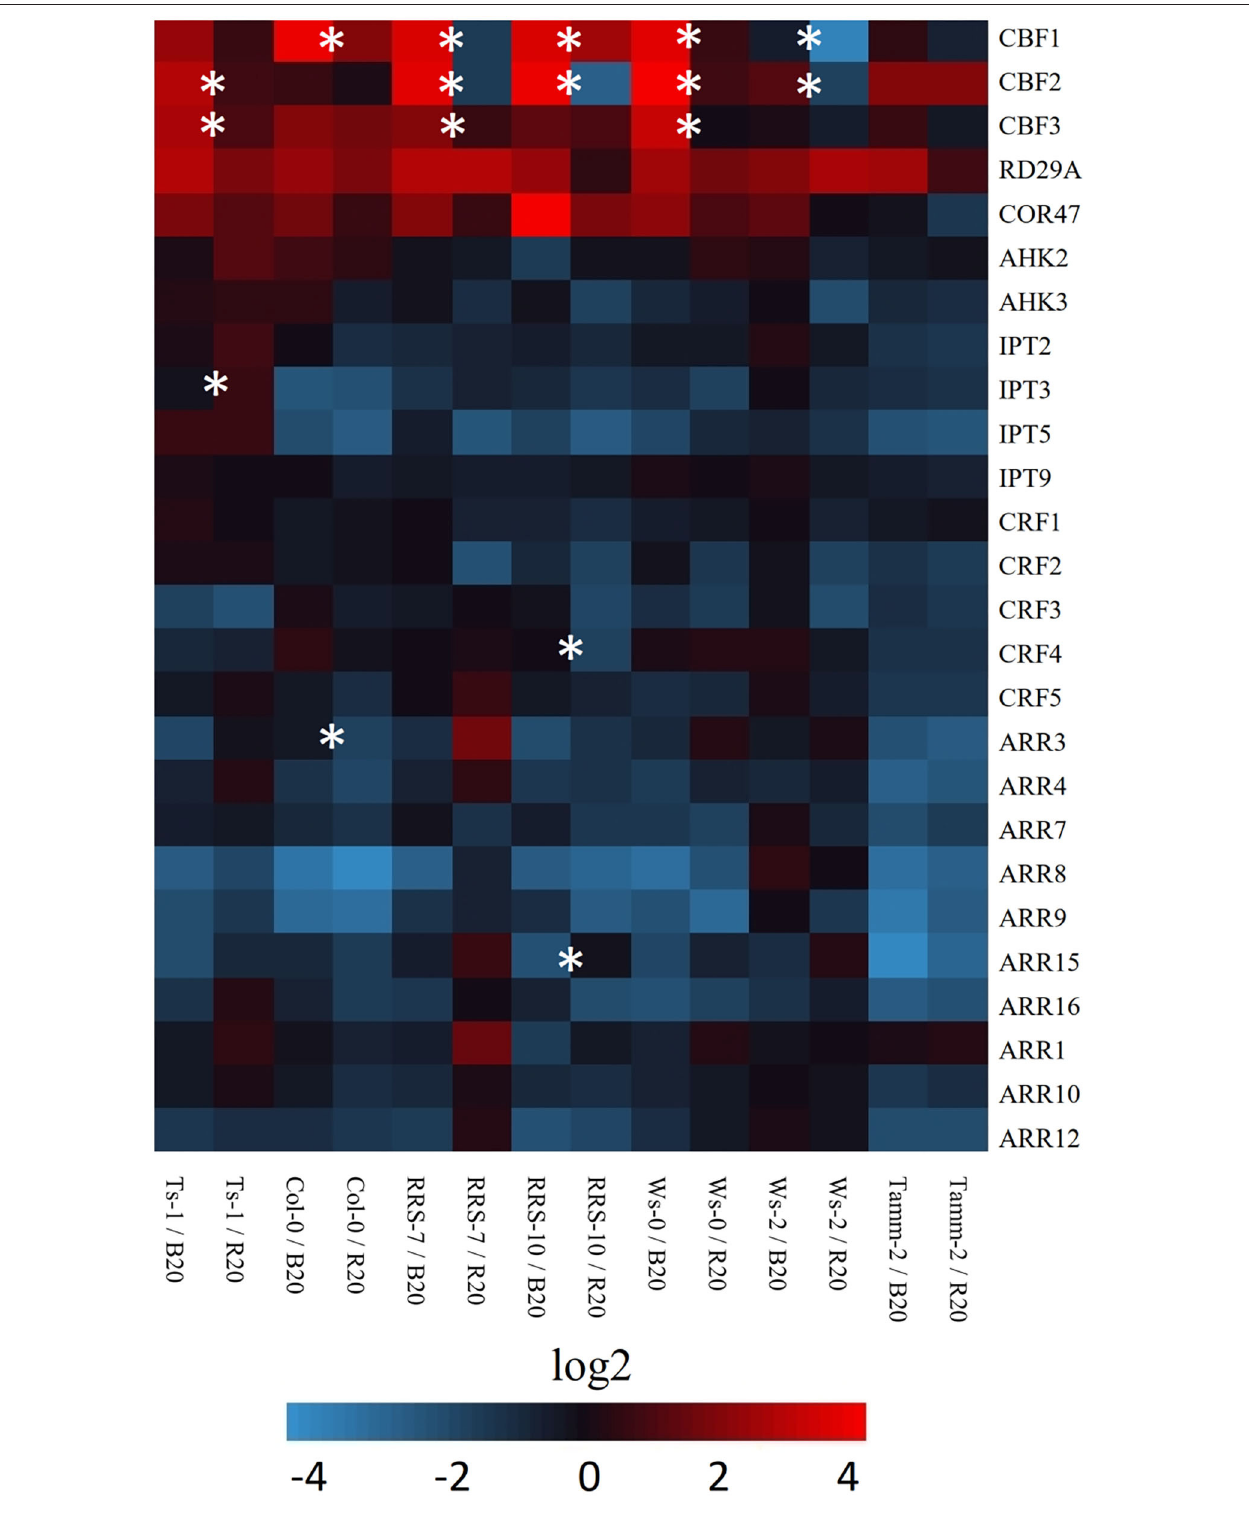
FIGURE 5 | Heat map visualization of expression of selected cold-related and cytokinin-related genes. The expression was measured in leaves of Arabidopsis accessions treated 7 days by low temperature under red (R20, 20 µ mol m − 2 s − 1 ) or blue light (B20, 20 µ mol m − 2 s − 1 ) conditions by RT-qPCR. Data were normalized as specified in Material and methods. Results are means of three biological replicates, and asterisks indicate significant differences between red and blue light-grown accession according to Student’s t -test ( p < 0.05). Accessions Ts-1, RRS-7, RRS-10, Ws-0, Ws-2, and Tamm-2 are described in Supplementary Material S4 .